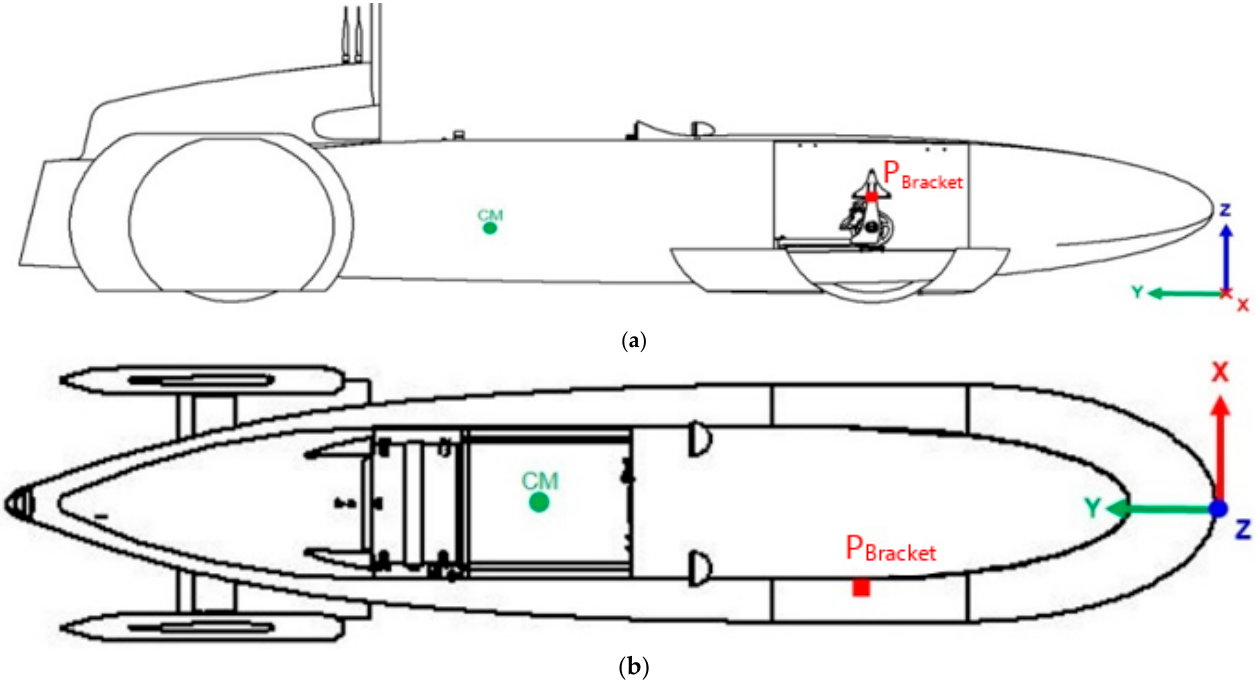
Figure 3. Prototype drawing view: ( a ) Lateral view and ( b ) top view. (center of mass ( • ), contact point ( )).